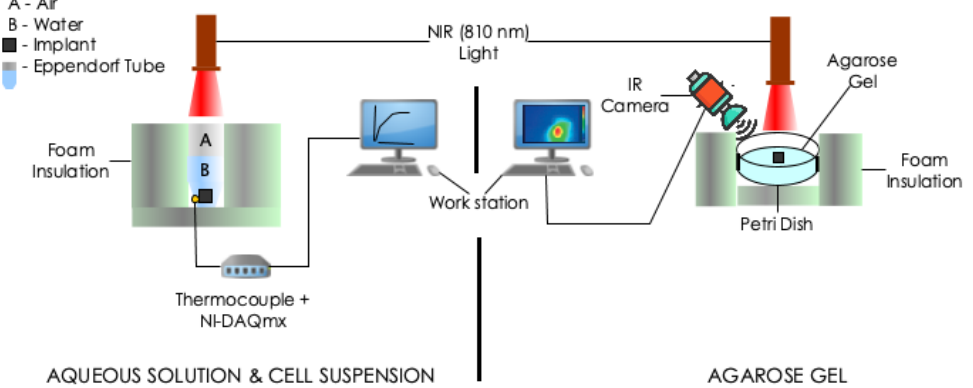
Figure 2. Schematic of the experimental setups for photothermal measurments. The experiments involved the irradiation of implant(s) embedded in: ( Left ) 0.5 mL deionized water or cell suspension contained in a 1.5 mL Eppendorf tube and ( Right ) agarose gel contained in a plastic Petri dish with a different power of NIR radiation at λ = 810 nm. Temperature measurements were taken with a thermocouple or IR